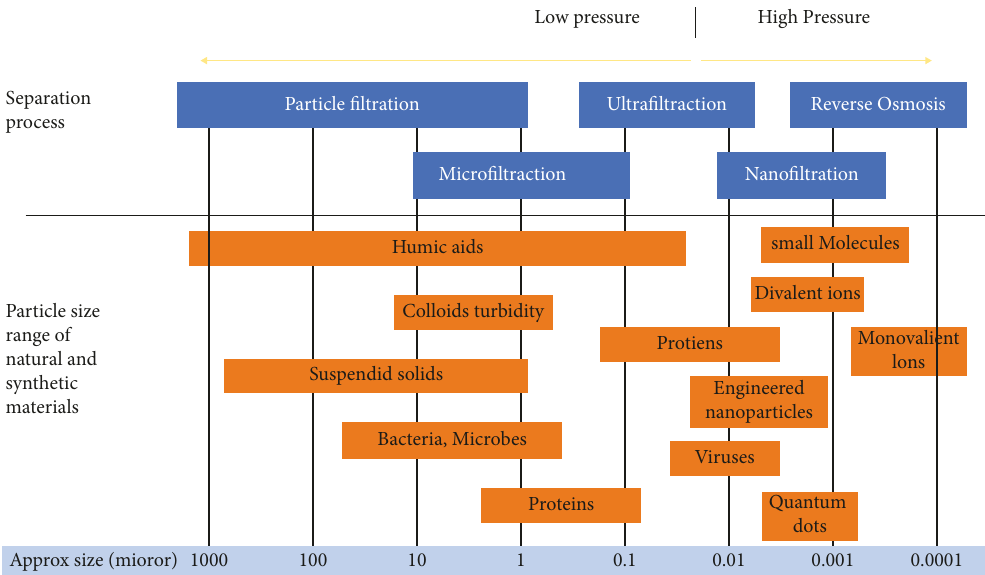
Figure 3: Comparison of water filtration membrane pore size with water contaminant size, reproduced from open source